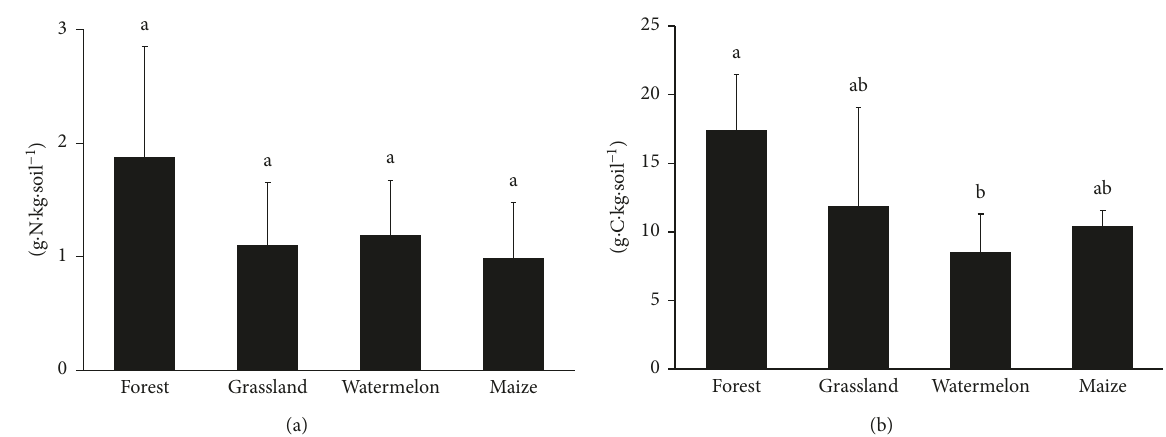
Figure 3: Mean SD (a) total nitrogen and (b) total carbon contents of the soil under different land use types. Different lowercase letters above the bars indicate significant differences among the land use types (one-way ANOVA, p grassland, watermelon, and maize sites, ±